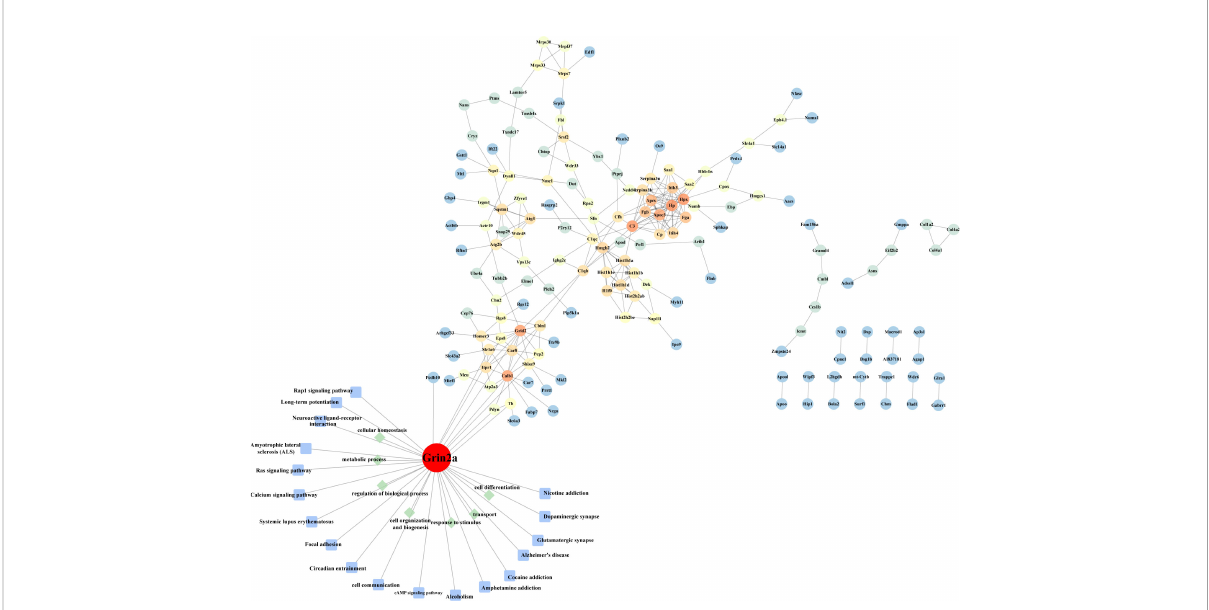
FIGURE 3 Protein-protein interaction network. The differentially expressed proteins in the heatmap were subjected to build a protein interaction network. GO and KEGG annotations were performed on the molecule GluN2A (encoded by Grin2a) we